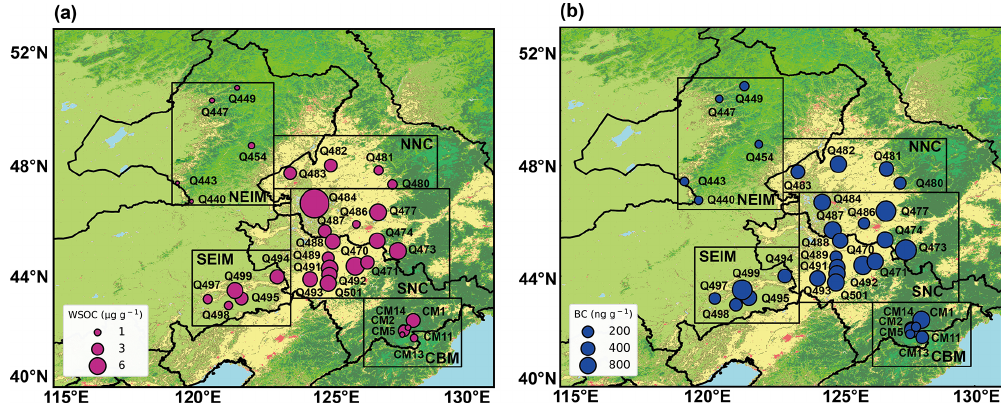
Figure 2. Spatial distributions of concentrations of (a) WSOC and (b) BC in snow samples. Sampling sites are divided into the five groups defined in Fig. 1. Bubble sizes are proportional to concentrations of WSOC and